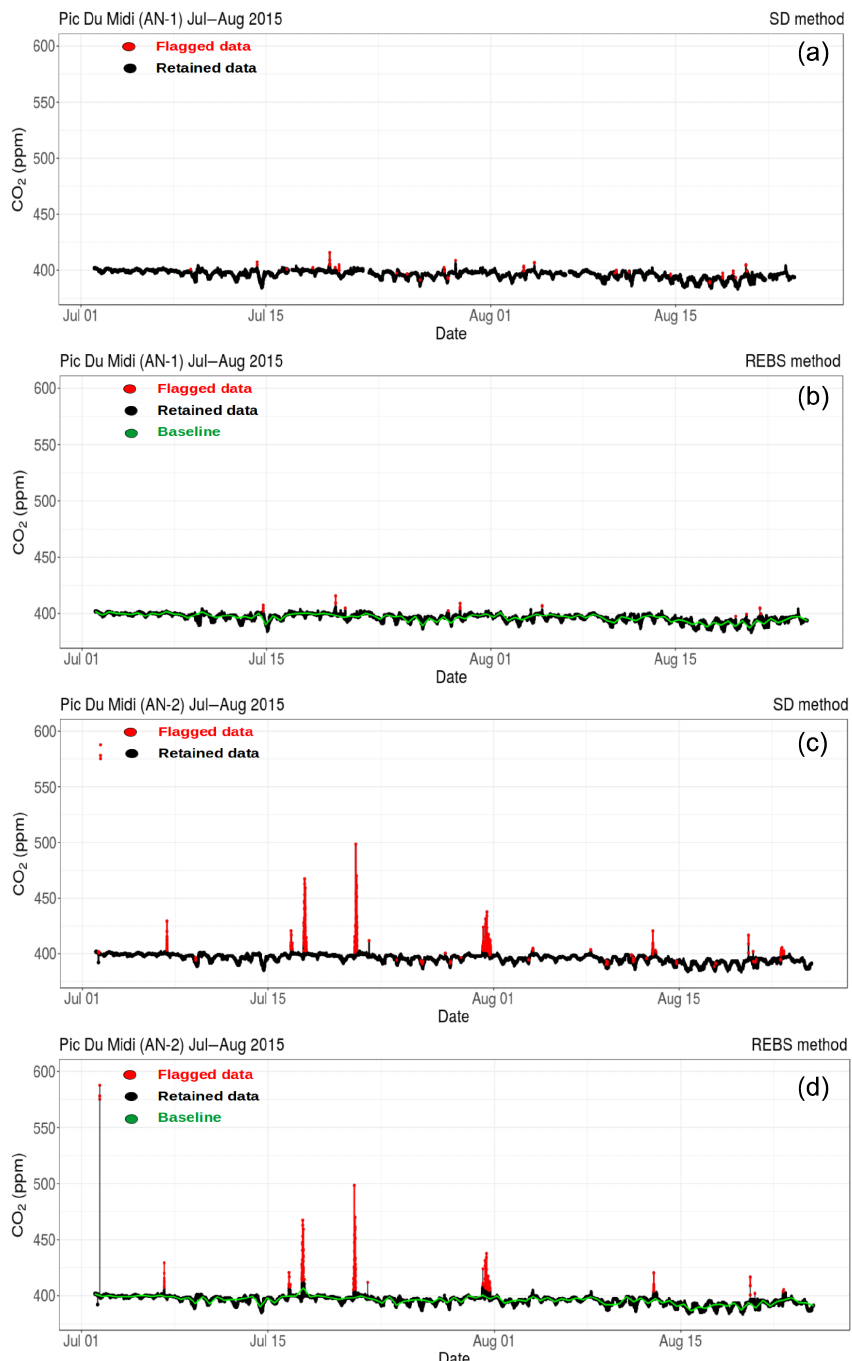
Figure 4. AN-1 CO 2 measurement at T55 building in panels (a) and (b) and AN-2 TDF building in panels (c) and (d) . Black data points are the retained measurements; red points represent the flagged using SD method in panels (a) and (c) and REBS method in panels (b) and (d) .